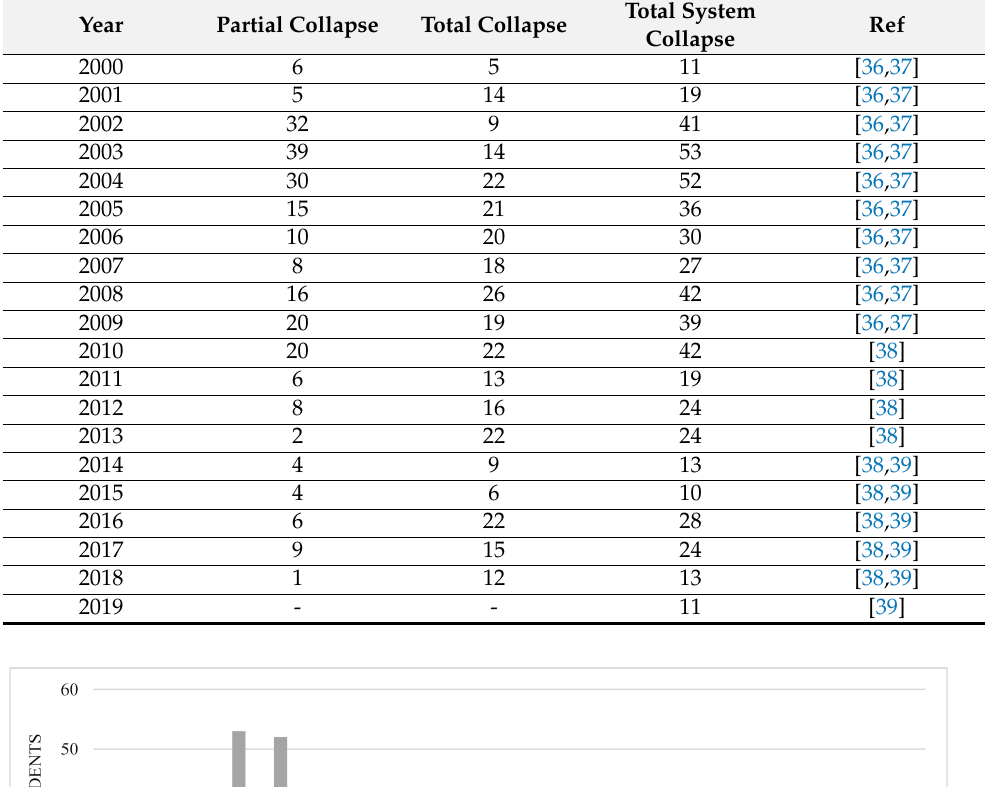
Table 3. Total System Collapses, 2000–2019.